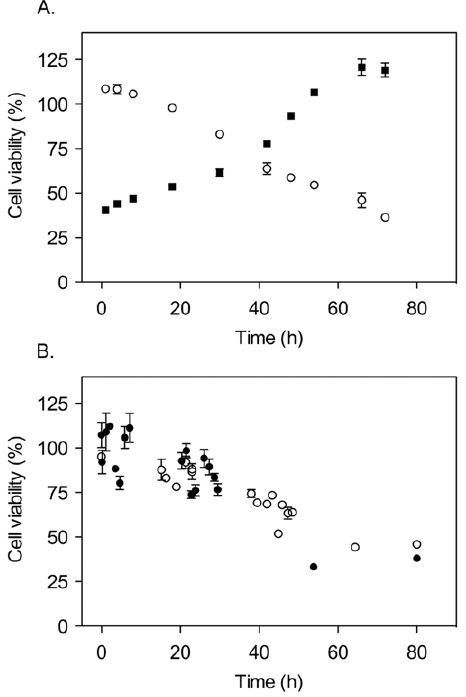
Figure 5. ApoSOD1 toxicity builds up over time and can be halted by Zn 2 + addition. 10 m M monomeric apoSOD1 was first added to multiple wells of SH-SY5Y cells and then washed away after different times of incubation. In parallel to washing, 10 m M monomeric apoSOD1 was also added to untreated cells. In a second line of experiments, 10 m M monomeric apoSOD1 [H46/48/120S] was added to the cells and, after different times of incubation, 20 m M of ZnCl 2 was added. MTT was added at the endpoint (72 h) of both experiments. Proteins were added in duplicate and data is presented as mean percentage of the buffer control 6 range. ( A ) Washing away the apoSOD1 protein after different length of incubation ( # ) induces the same toxicity as when adding the protein the same number of hours before the endpoint of the experiment ( & ). ( B ) Adding Zn 2 + to the cell media after different delay times has the same effect on cell viability as washing the protein away. Filled and empty symbols represent separate